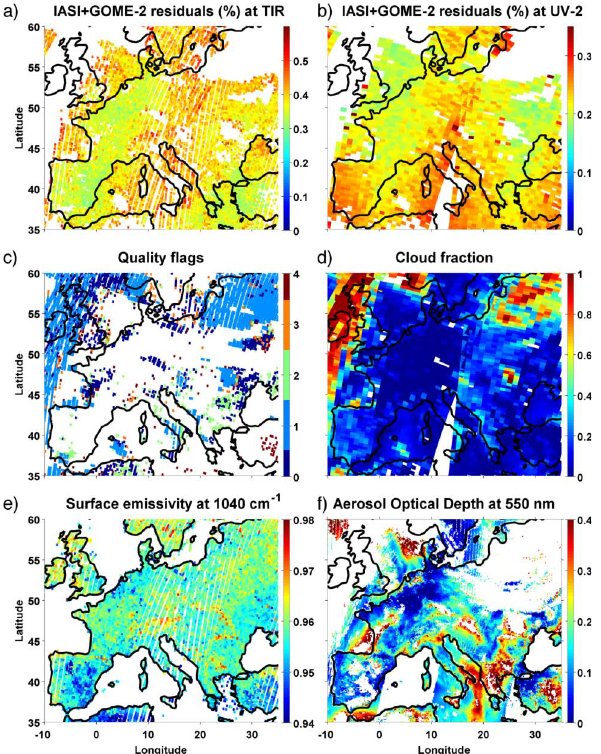
Fig. 3. Sensitivity comparison in terms of ( a and b ) diagonals of AVKs as a function of altitude, ( c and d ) degrees of freedom DOF col and ( e and f ) heights of maximum AVK (km a.g.l.) H max , the last col 2 for partial columns from the surface up to the altitude indicated in abscissa (from 1 to 6km a.s.l.); for IASI+GOME-2 (red), IASI only (green) and GOME-2 (blue) ozone retrievals for an average of pixels over land (left) and over ocean (right) over Europe on 19– 20 August